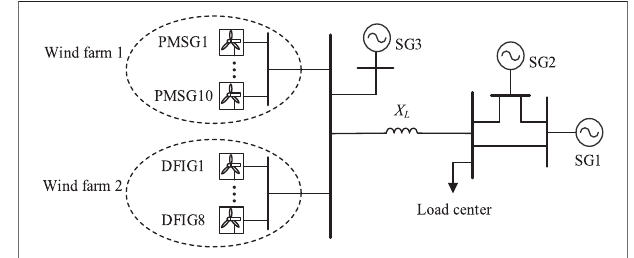
FIGURE 6 | Con fi guration of example system.